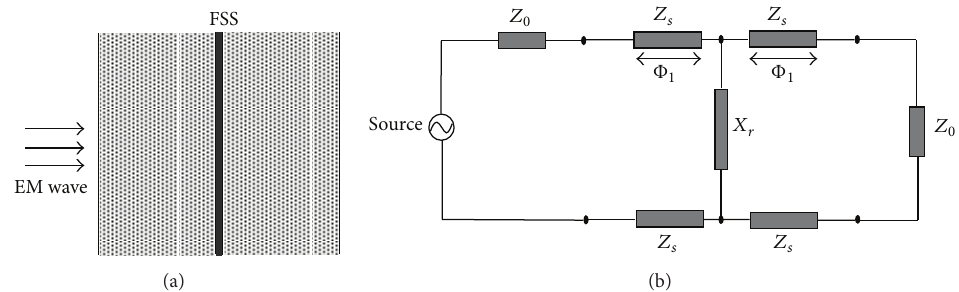
Figure 2: (a) Schematic of the monolithic half-wave slab centrally loaded with SSL-FSS and (b) its equivalent